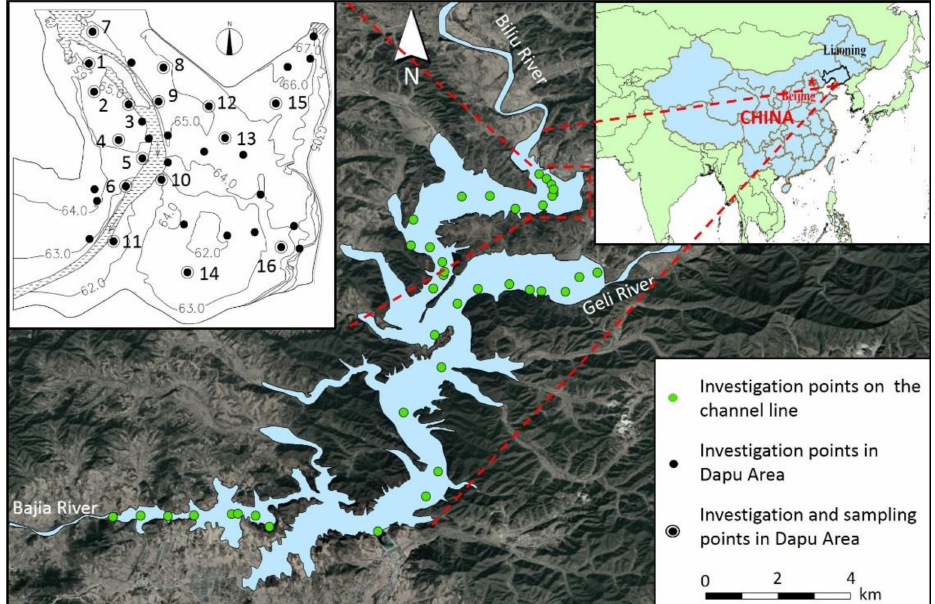
Figure 1. The distribution of the survey